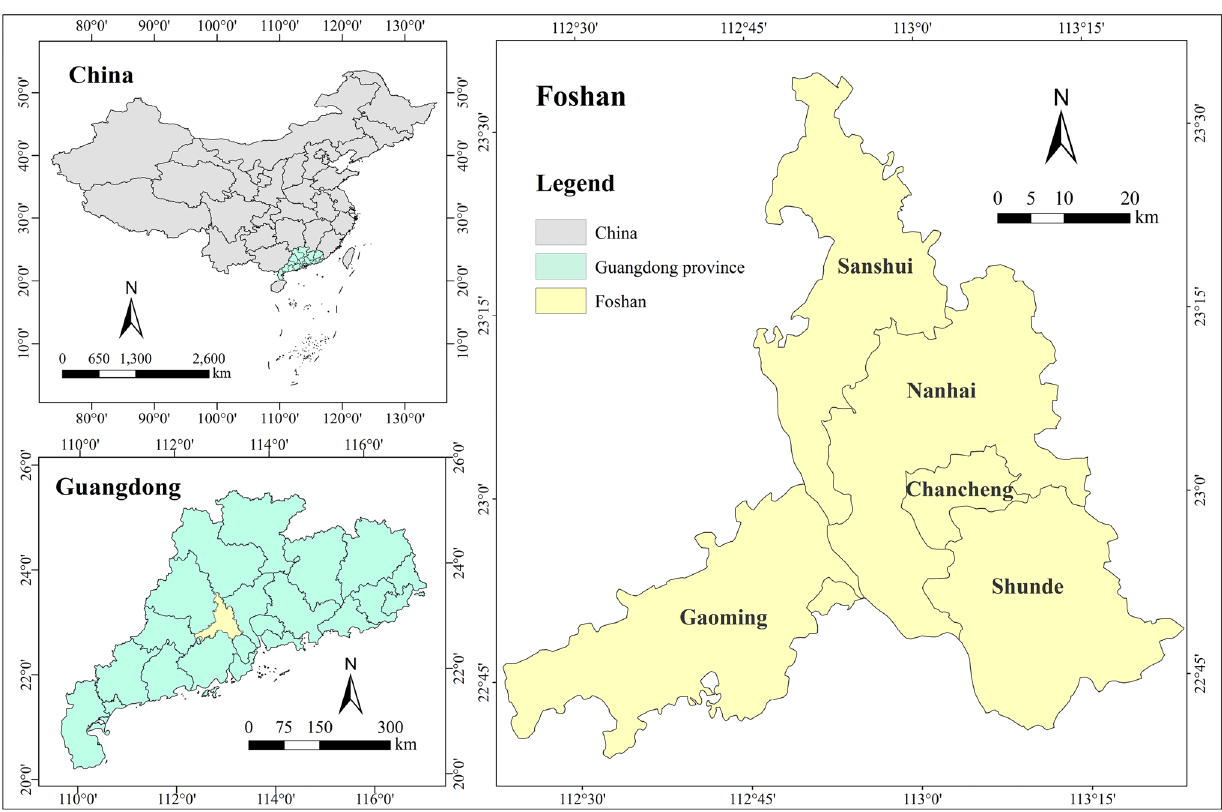
Fig.1 Study area (location map)